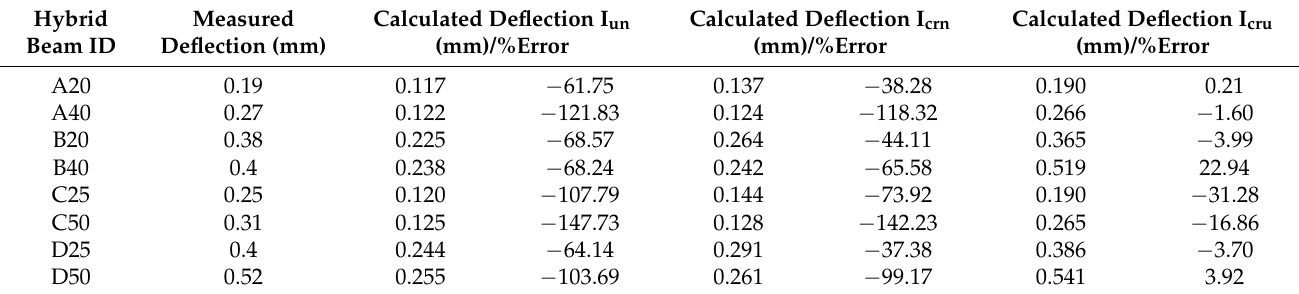
Figure 18. Comparison of measured and calculated deflection at cracking. Table 11. Measured and Calculated deflection of hybrid